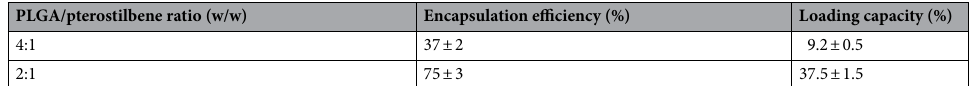
Table 3. Drug loading efficiencies and loading capacities for PTB-PLGA NPs prepared with different polymer/drug